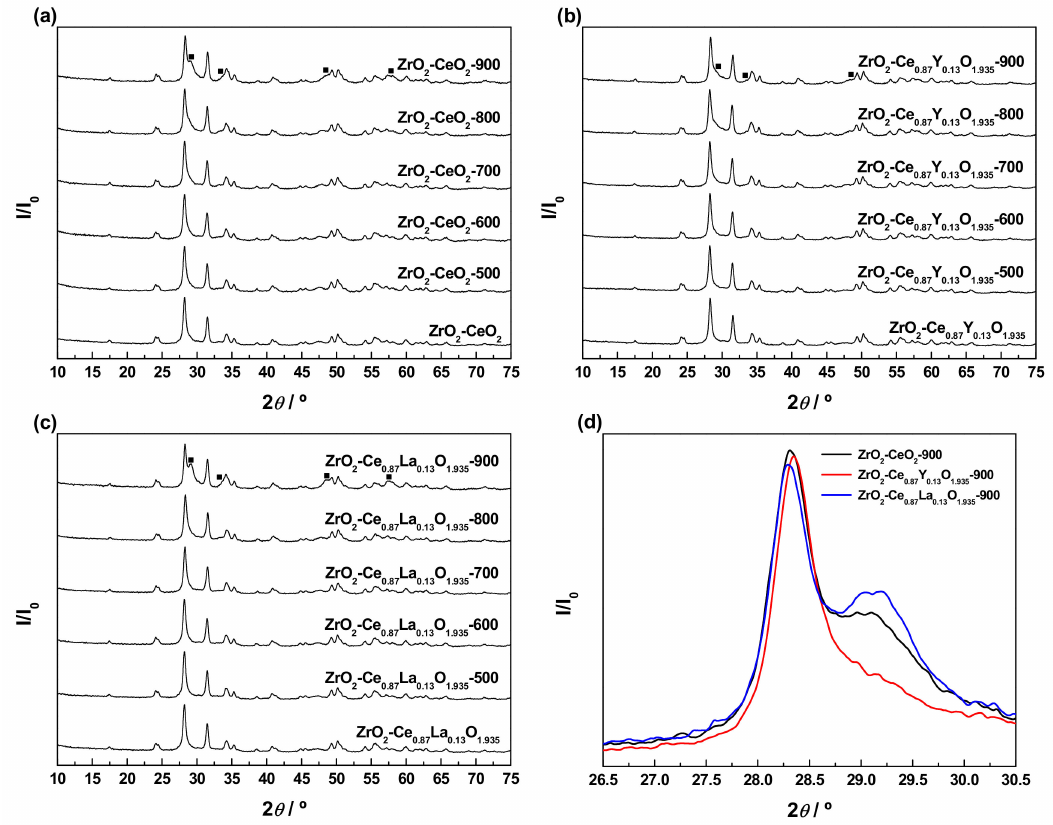
Figure 9. ( a – c ) XRD patterns recorded for the undoped and Ln-doped ZrO 2 -CeO 2 samples, subjected to successive thermochemical ageing treatments at increasing reduction temperatures from 500 to 900 ◦ C. ( d ) Enlargement of the (111) di ff raction peak of monoclinic ZrO 2 for the undoped and Ln-doped ZrO 2 -CeO 2 samples subjected to the whole series of reduction treatments up to 900 ◦ C. Caption: (cid:4) Ce x Zr 1 − x O 2 − δ